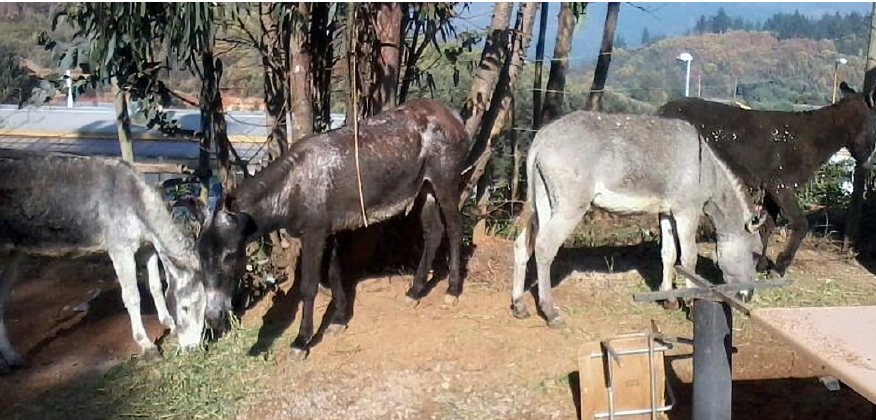
Figure 6. Donkeys D1–4 fully recovered, eating alfalfa hay and grass ( Medicago sativa and Lolium perenne ) 90 days after the fire. Left to right is D4, D2, D3, and D1. Table 2. Complete blood count and serum biochemistry profile of two burned donkeys (D3–D4).